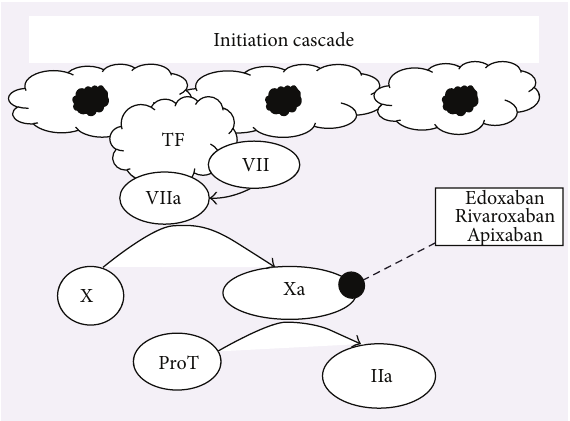
Figure 1: Adapted with permission: Zalpour and Oo [8]. Abbrevia- tions: TF, tissue factor; VII, factor VII; VIIa, activated factor VII; X, factor X; Xa, activated factor X; ProT, prothrombin; IIa, thrombin; IX, factor IX; IXa, activated factor IX; Xa, activated factor X; Va, activated factor V; VIIIa, activated factor VIII; vWF, Von Willebrand